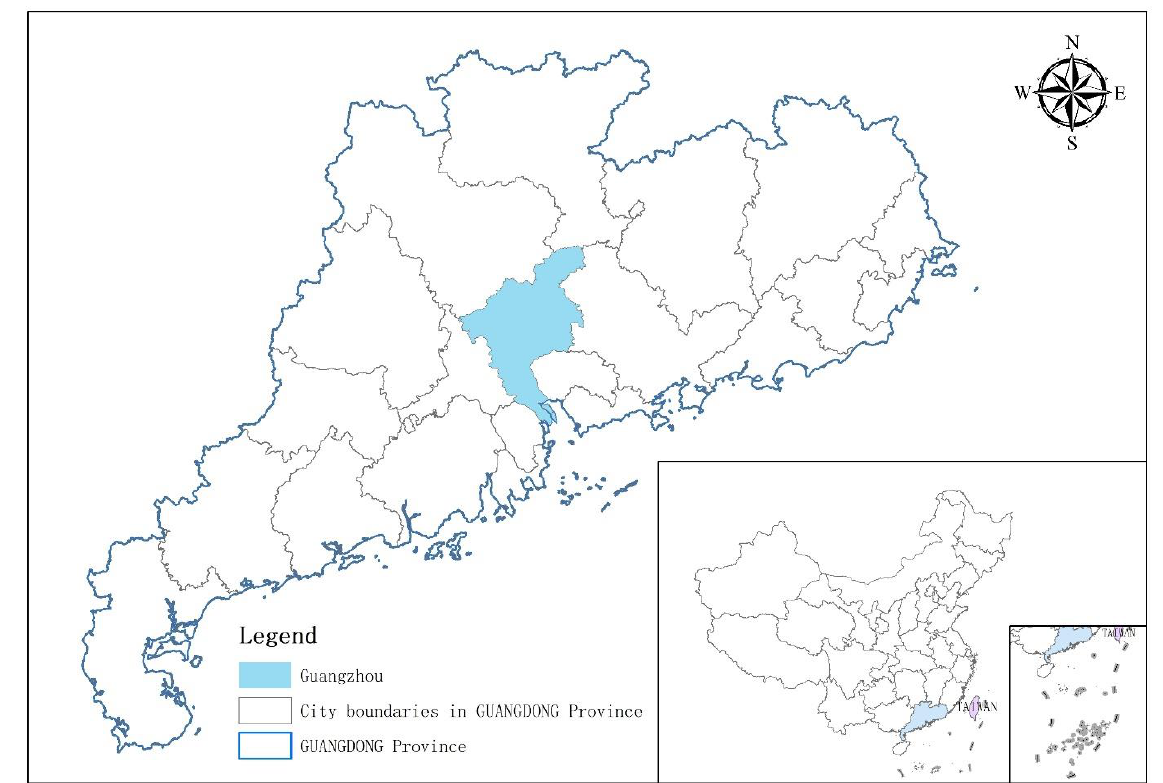
Figure 3. The location of